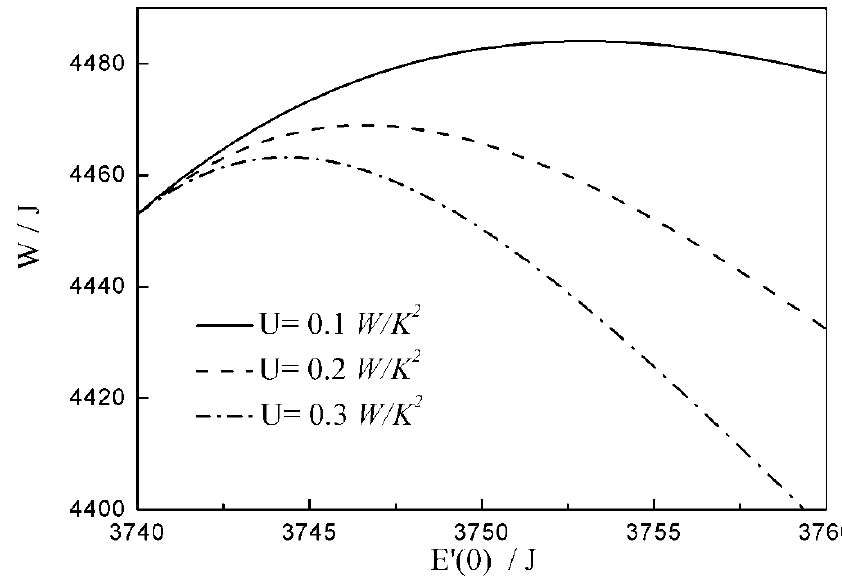
Figure 7. Work production W versus the values of E (cid:48) ( 0 ) with variable heat conductance U as n = 2.